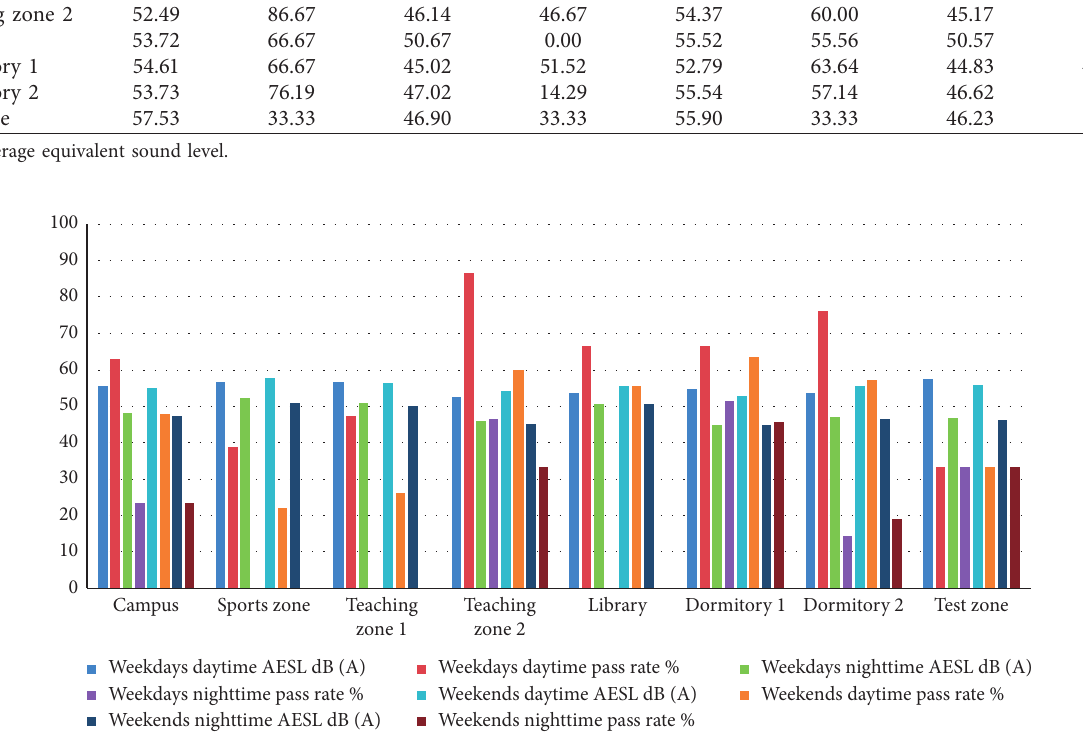
Figure 4: Distribution of average equivalent sound level in each